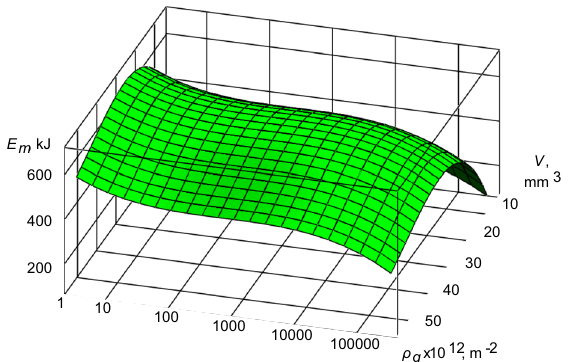
Figure 3. The energy-mass transfer in the TS “crankshaft-insert” for the operating conditions of diesel engine 10D100 during the partial self-organizing